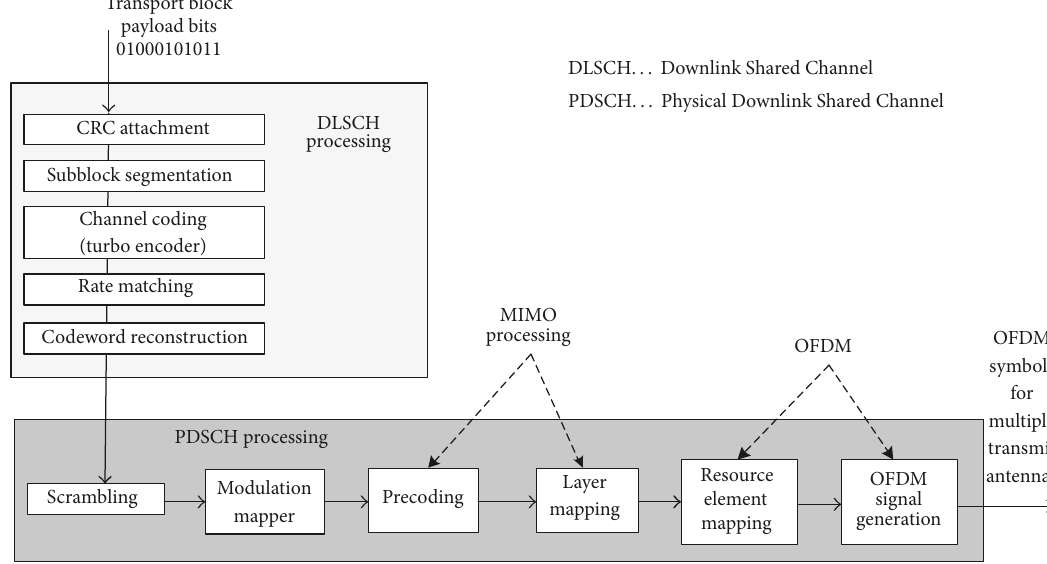
Figure 7: LTE signal processing block diagram for transmit diversity and spatial multiplexing (MIMO) [27] in the